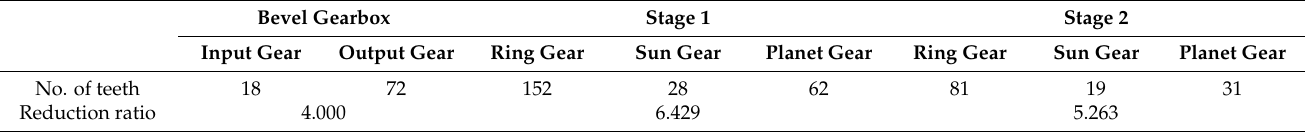
Figure 4. The structure of Stages 1 and 2 planetary gearboxes [14].